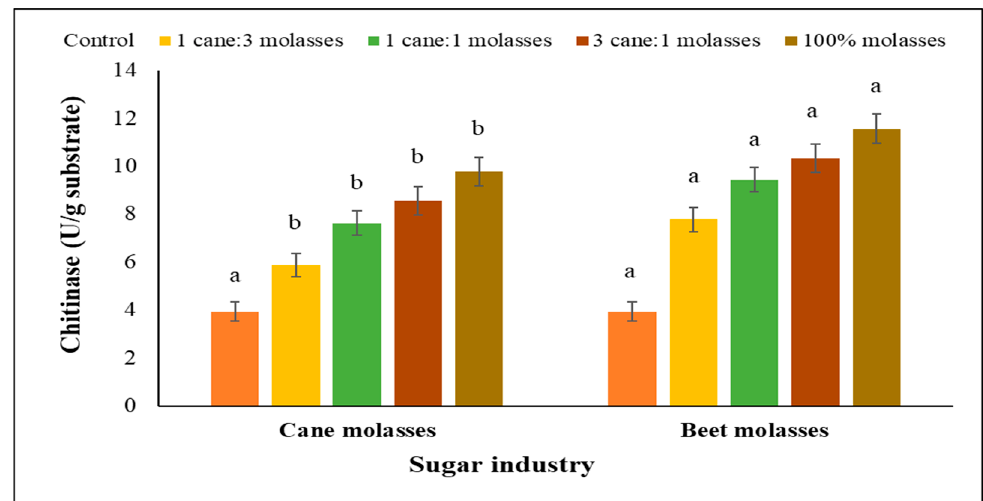
Figure 5. Effect of sugar industry concentration on the production of chitinase on SSF by T. funiculosus strain CBS 129594. The values are the means of three replicates with standard deviation (±SD). Mean values in each bar followed by a different lower-case letter are significantly different according to Duncan’s multiple range tests at p ≤ 0.05.